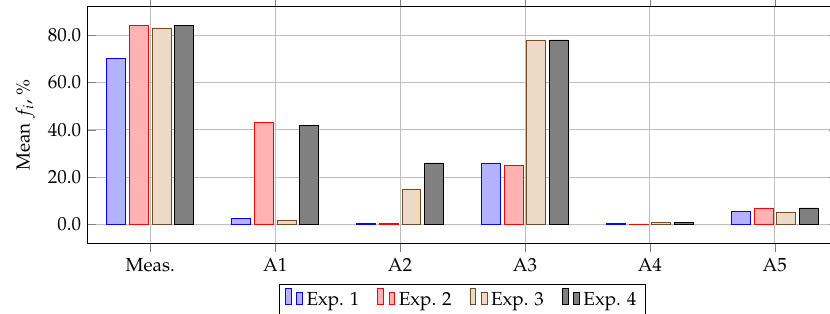
Figure 7. Average current error of filtration methods. VersionOctober24,2021submittedto JournalNotSpecified 15of18